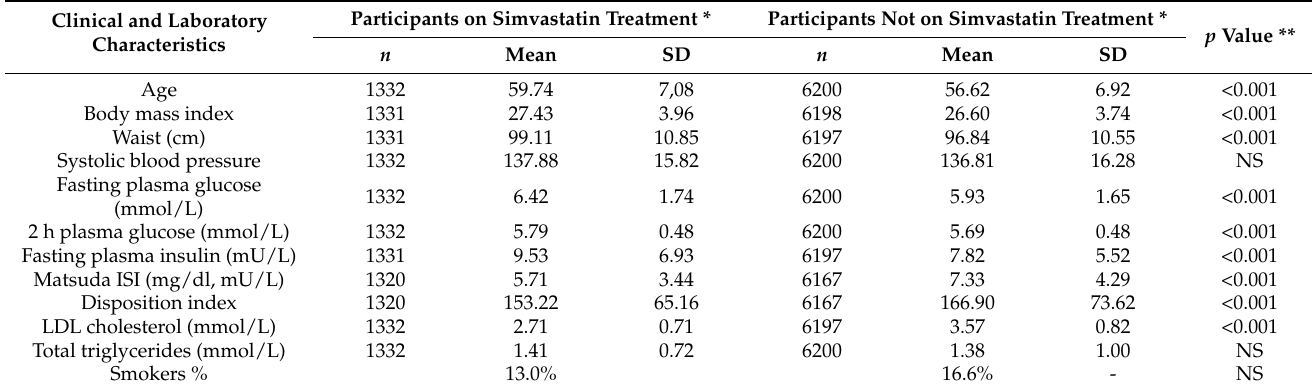
Table 1. Clinical and laboratory characteristics of participants without statin treatment and partici- pants on simvastatin